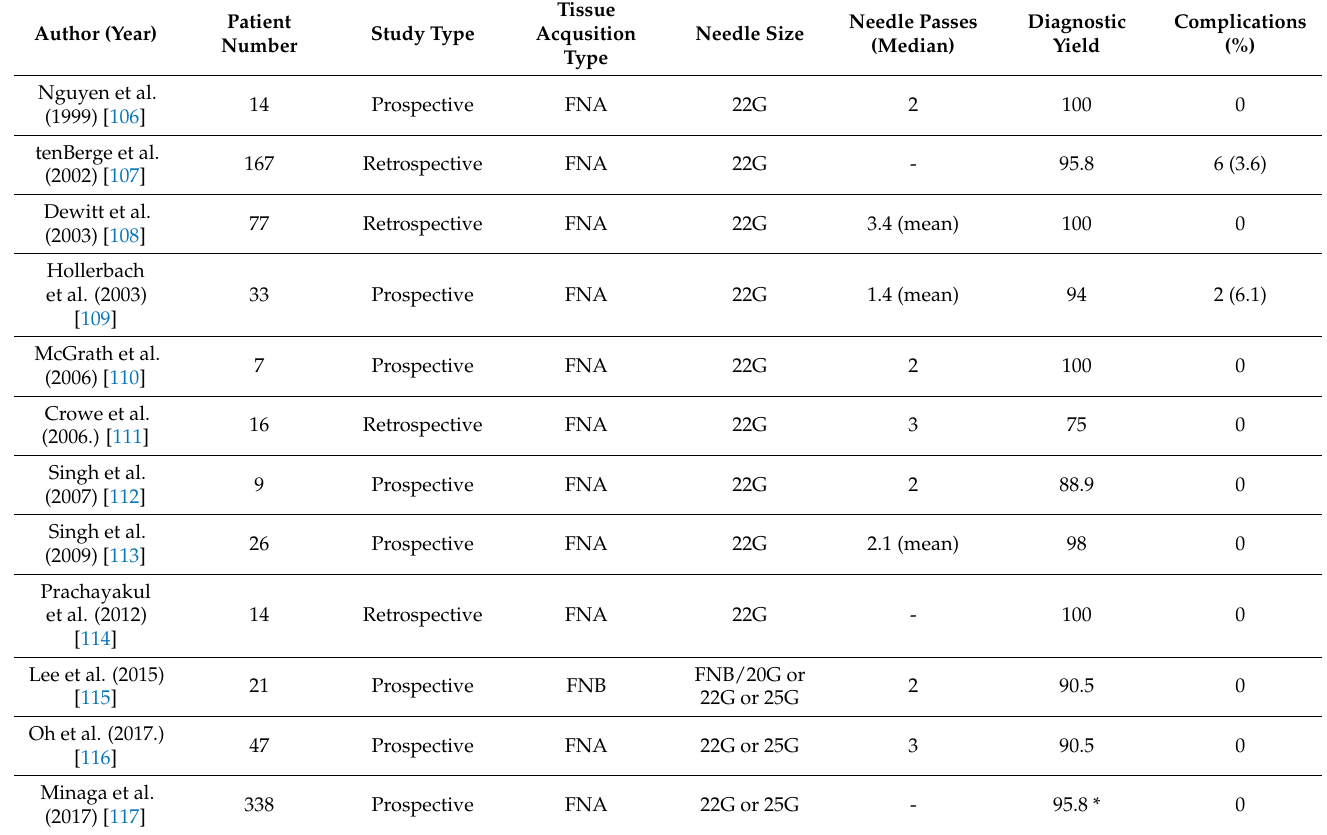
Table 3. Summary of studies reporting EUS FNA or FNB use in focal liver